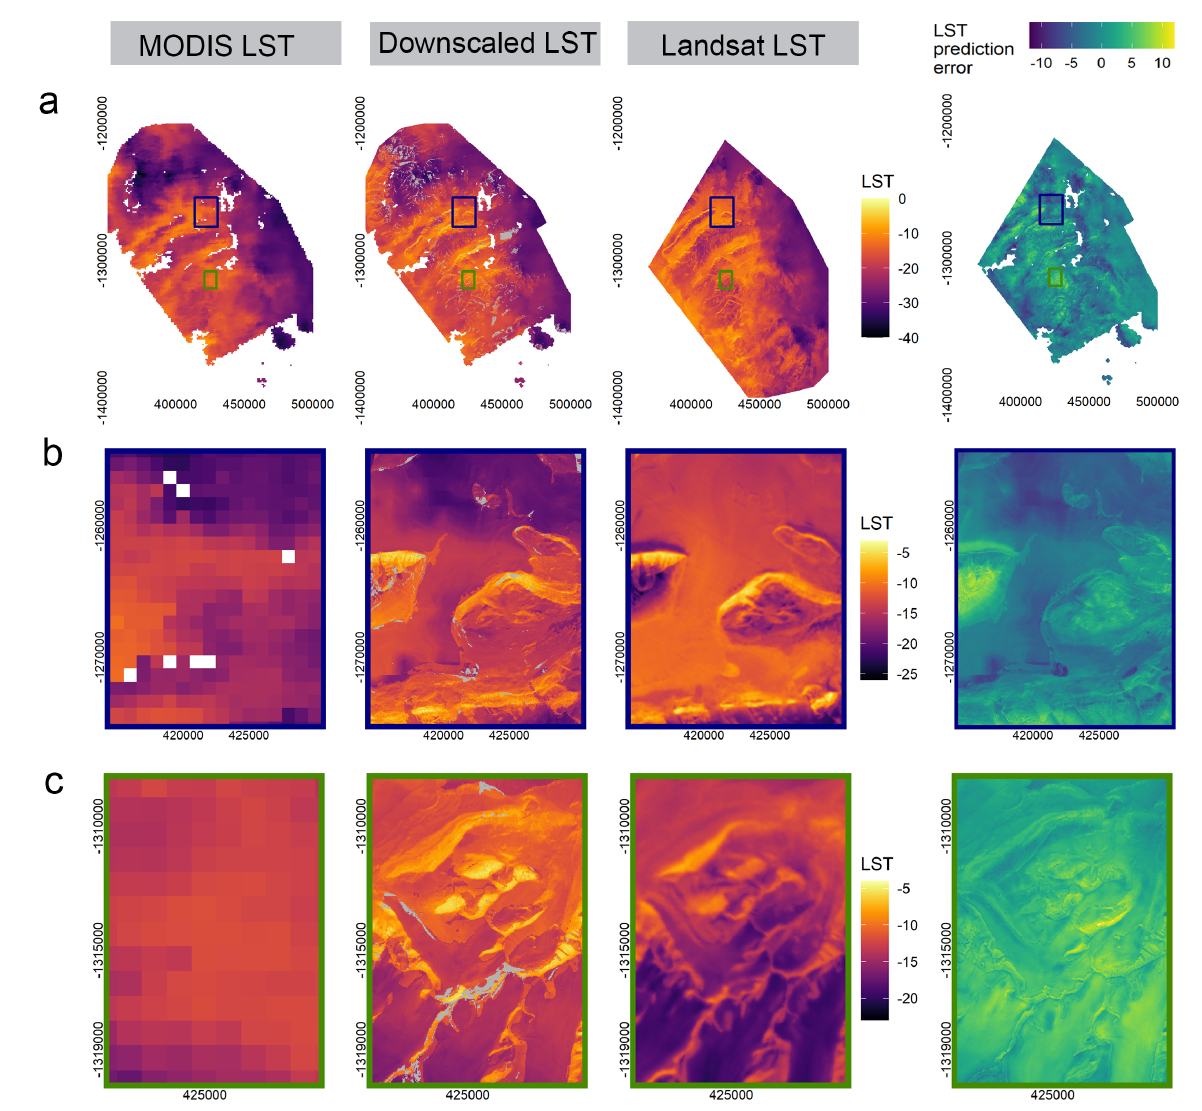
Figure 6. Comparison of original MODIS LST, downscaled LST and high resolution reference LST data from Landsat 8 (in ◦ C) and the LST prediction error, i.e., the difference between the downscaled and the reference scene (in the columns from left to right) in a MODIS scene from Aqua from the 12 November 2018, 13:50 UTC, 2:50 am NZDT with a solar altitude of 29.99 ◦ and azimuth of 4.98 ◦ . The corresponding Landsat scene was captured 11 min after MODIS at 14:01 UTC. ( a ) full area of interest and the extents of figures ( b , c ) as blue ( b ) and green boxes ( c ). White areas indicate that data was not available and grey areas indicate that the sample was outside of the